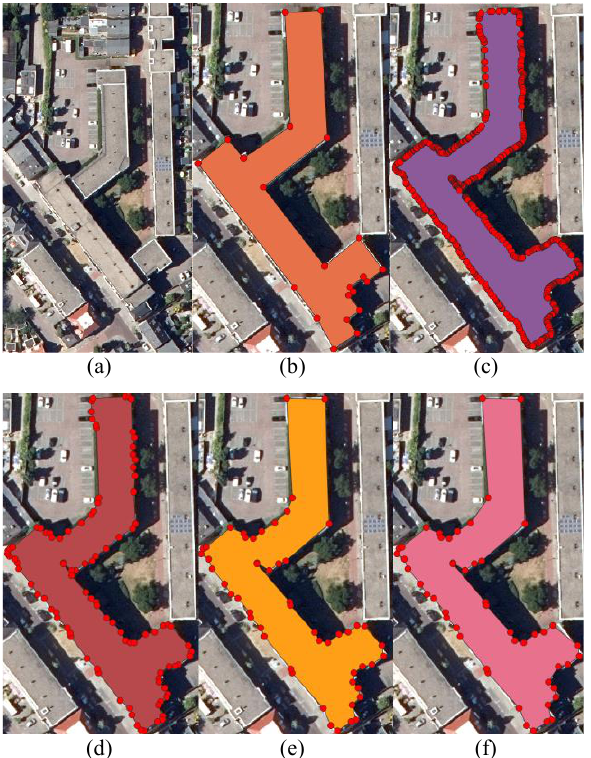
Figure 8. Example polygon obtained with different tolerance values using the composite images (RGB + nDSM) for urban area dataset: (a) Aerial image, (b) Reference building footprints, (c) Predicted polygon with tolerance 0.125 pixel, (d) 1 pixel, (e) 5 pixel, (f) and 7